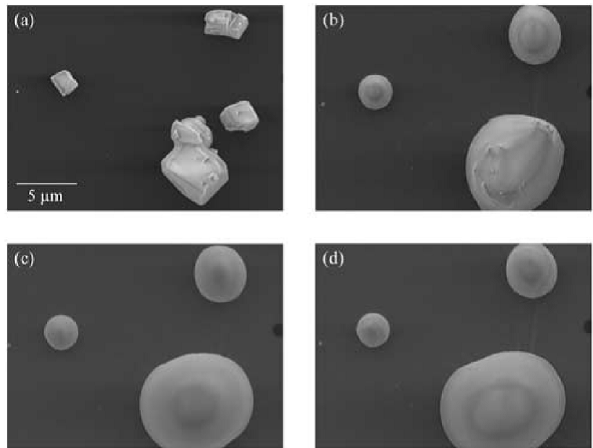
Figure 9. SEM images of CaCO 3 particles before and after expo- sure to 26ppbv gaseous HNO 3 at ∼ 41% RH. (a) Before expo- sure; (b) exposure for 1h; (c) exposure for 2h; (d) exposure for 4h. Reprint with permission by Krueger et al. (2003). Copyright 2003 John Wiley & Sons,